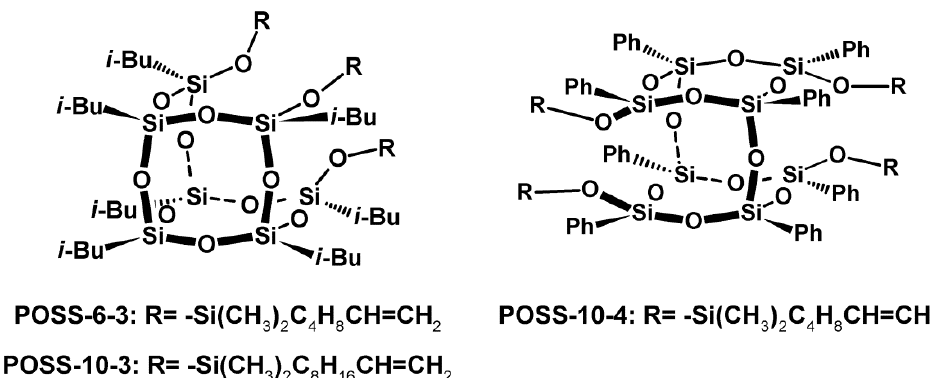
Figure 1. Structures of tri- and tetra-alkenyl-silsesquioxane comonomers.